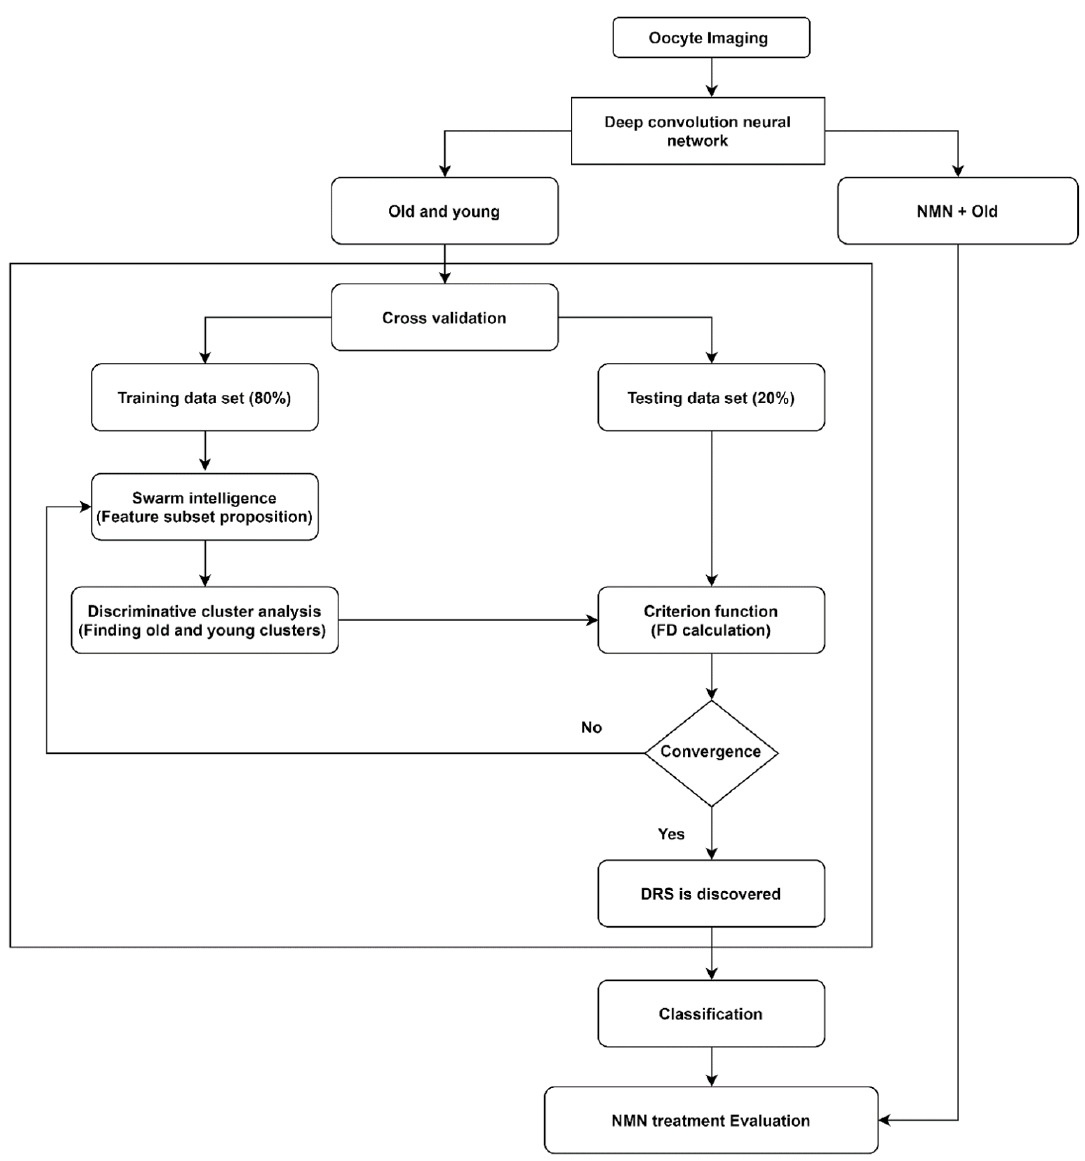
Figure 1. Data analysis methodology employed in this